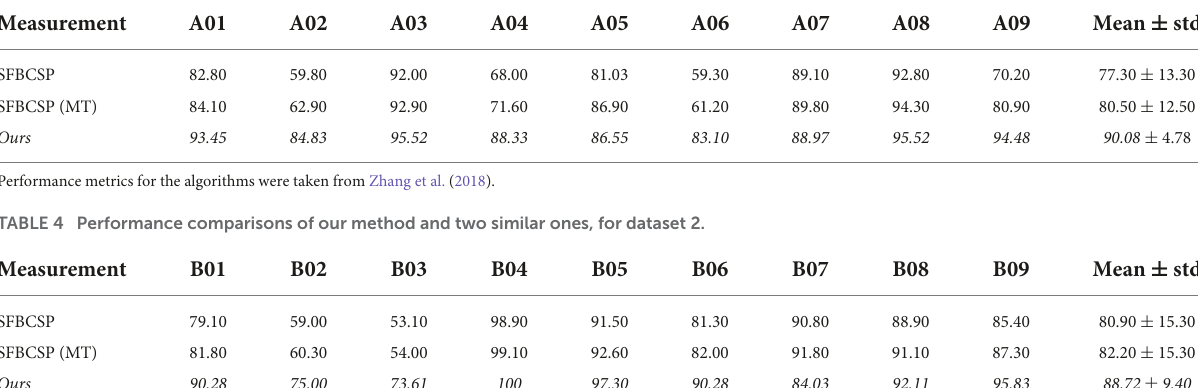
TABLE 3 Performance comparisons of our method and two similar ones, for dataset 1.